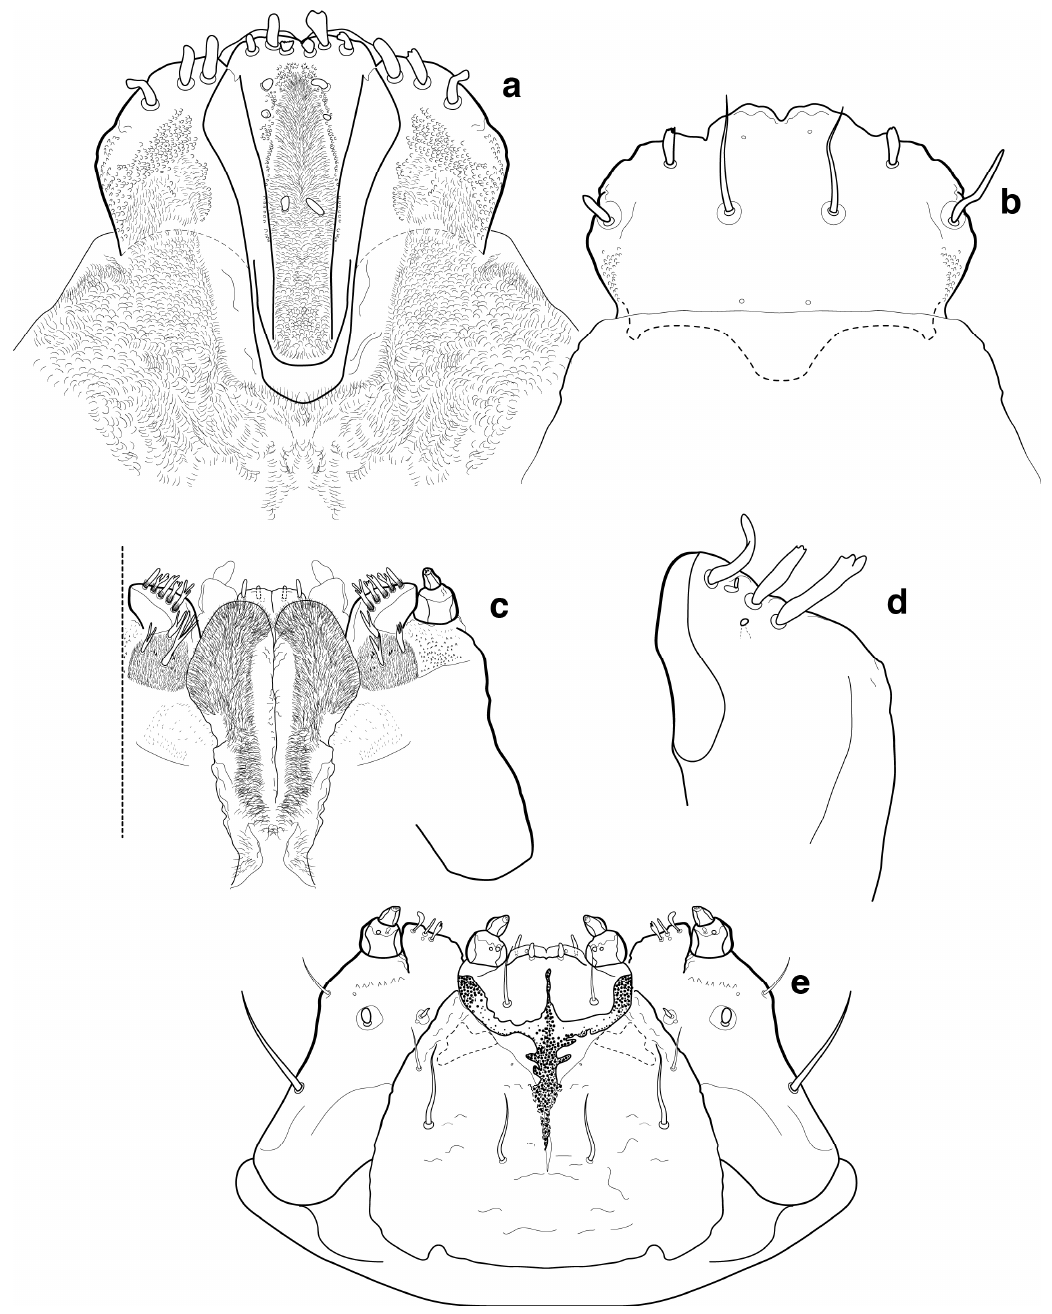
Figure 88. Trigonotarsus calandroides mouthparts: ( a ) epipharynx; ( b ) clypeus (incomplete) and labrum; ( c ) hypopharynx, and maxillary palp, dorsal view; ( d ) detail of mala and ventral malar setae; and ( e ) labio-maxillary complex, ventral view.